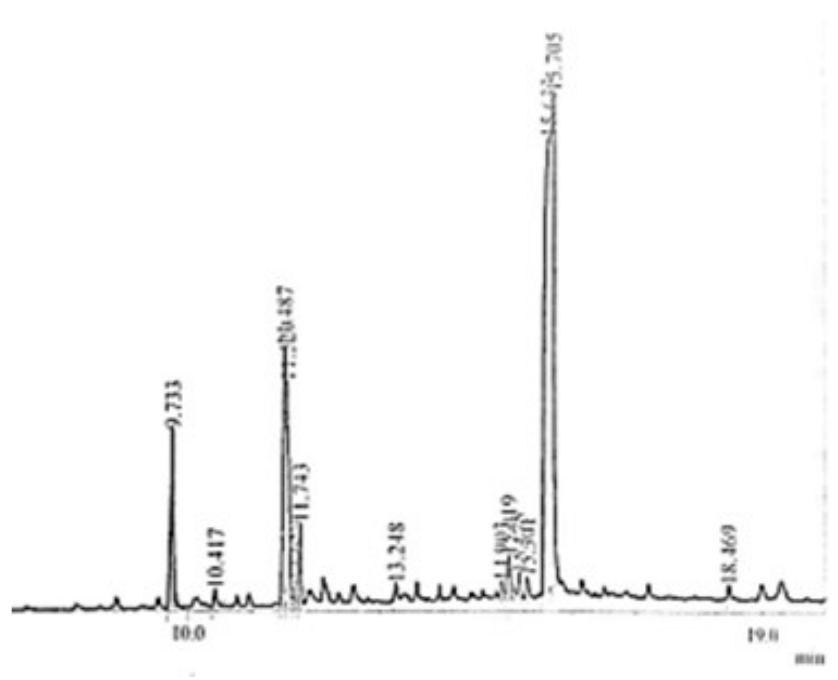
Figure 3. GC-MS chromatogram of chloroform fraction of C. colocynthis.